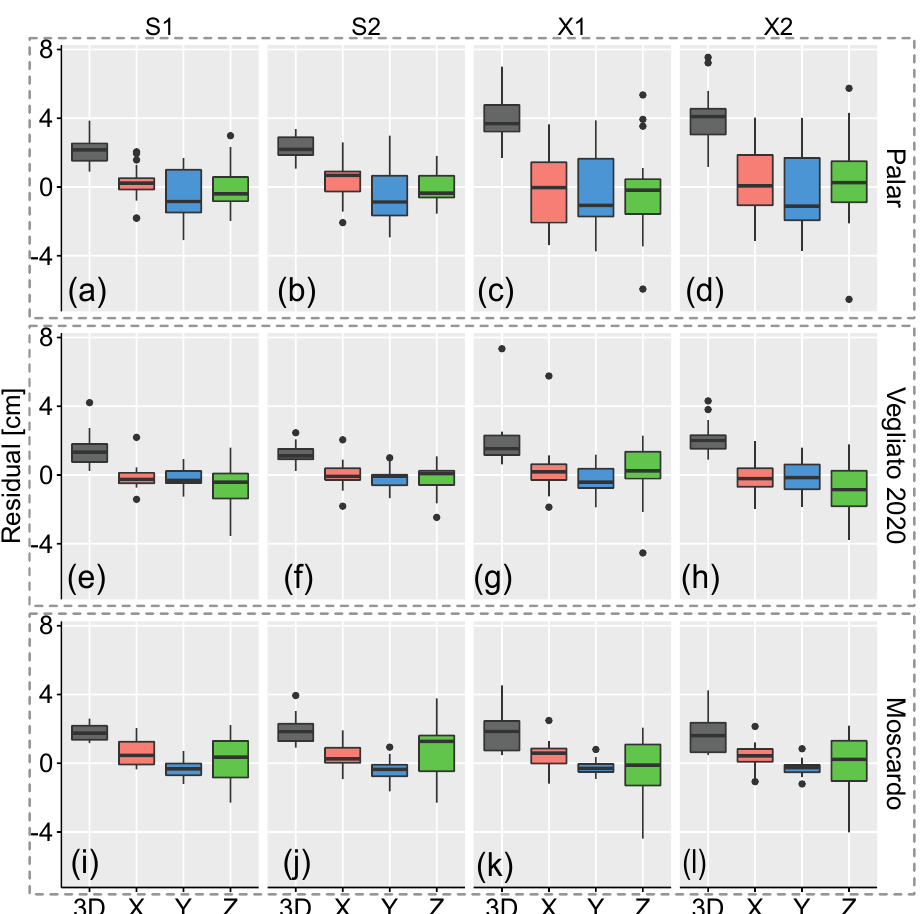
Figure 6. Comparison of CP residuals obtained from different surveys and study areas. ( a – d ) Palar, ( e – h ) Vegliato 2020, ( i – l ) Moscardo. ‘S’ were surveys performed with the Sony camera, whereas ‘X’ referes to X5S datasets. The 3D total error is reported in grey, while pink, blue and green represents residuals in the X , Y and Z direction, respectively. These results were obtained using all available GCPs for each study